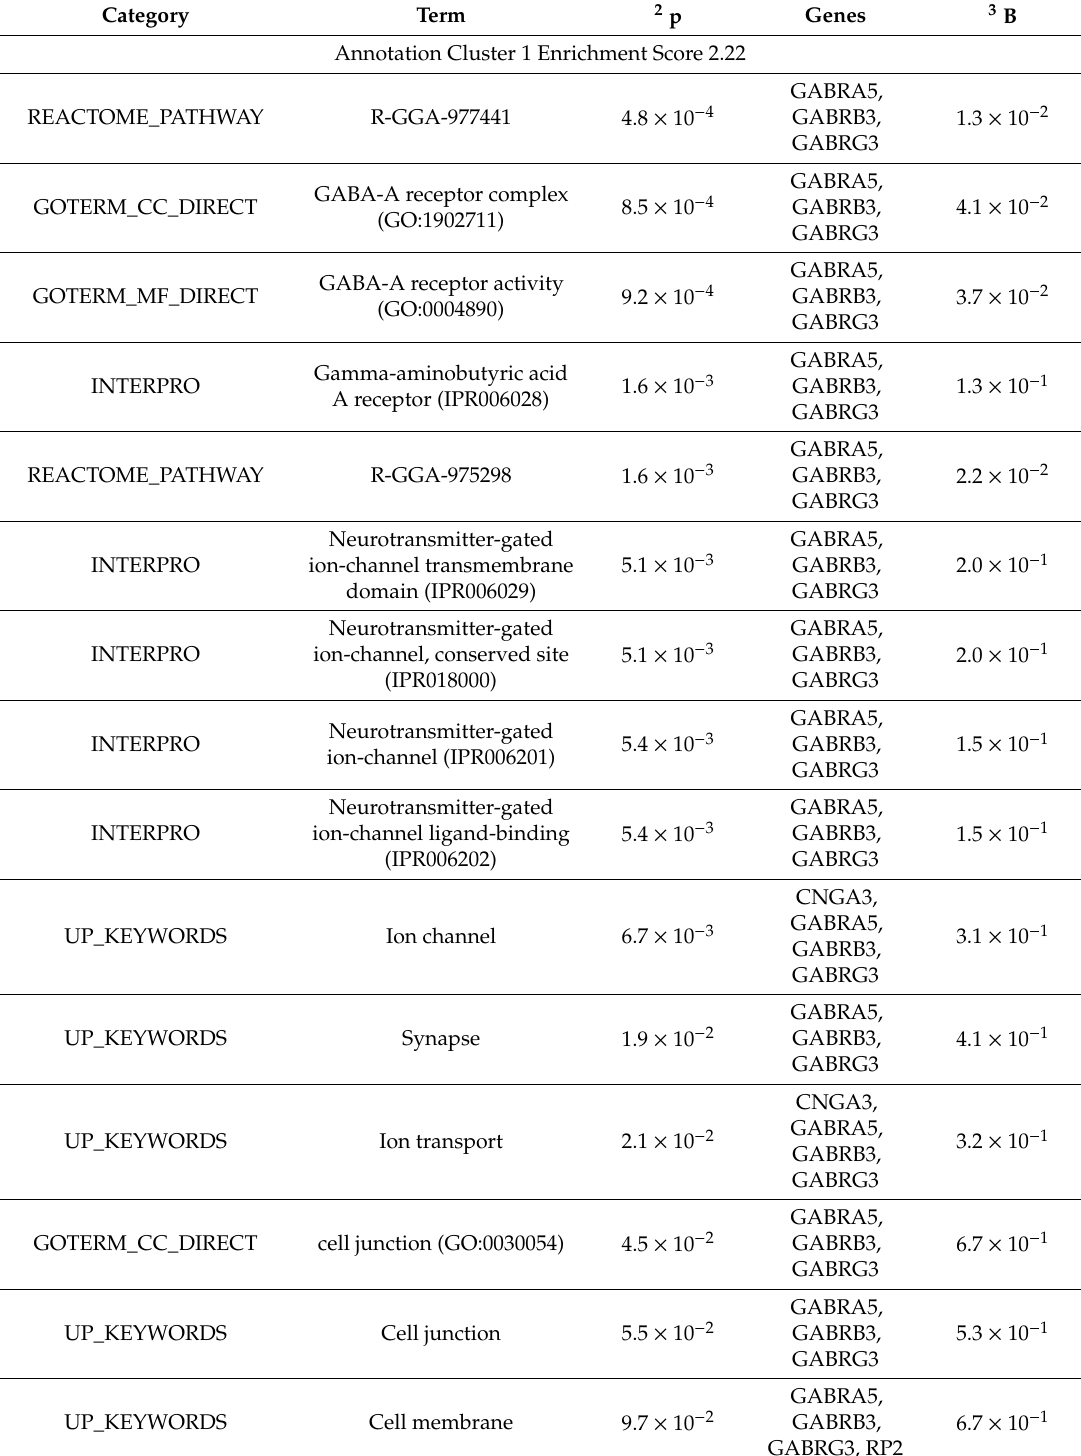
1 For trait abbreviations see Table 1; 2 p = p -value; 3 B = Benjamini test to correct for multiple